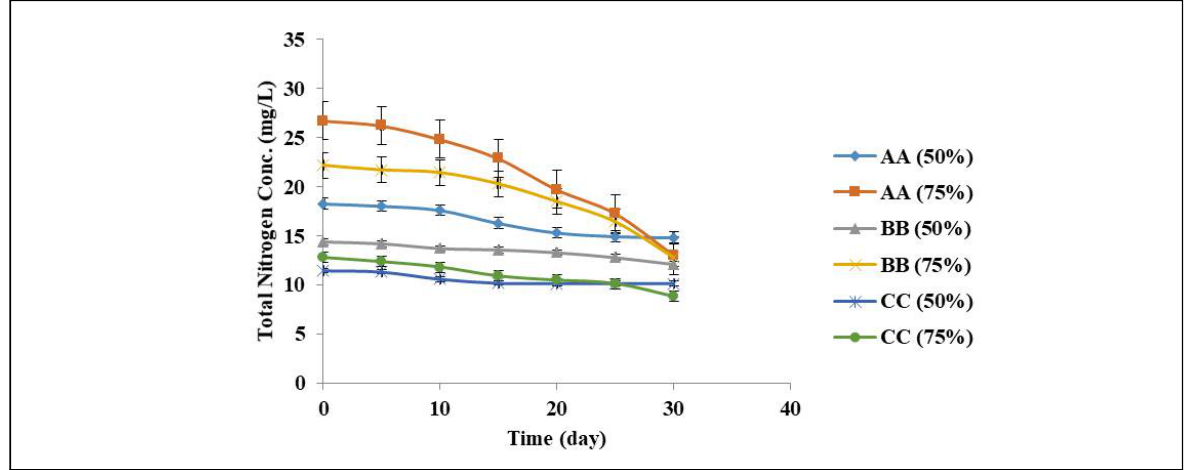
Figure 3.1: Graph of TN concentration in industrial wastewater and microalgae samples mixture AA, BB and CC at different proportions (50%, and 75%) for 30